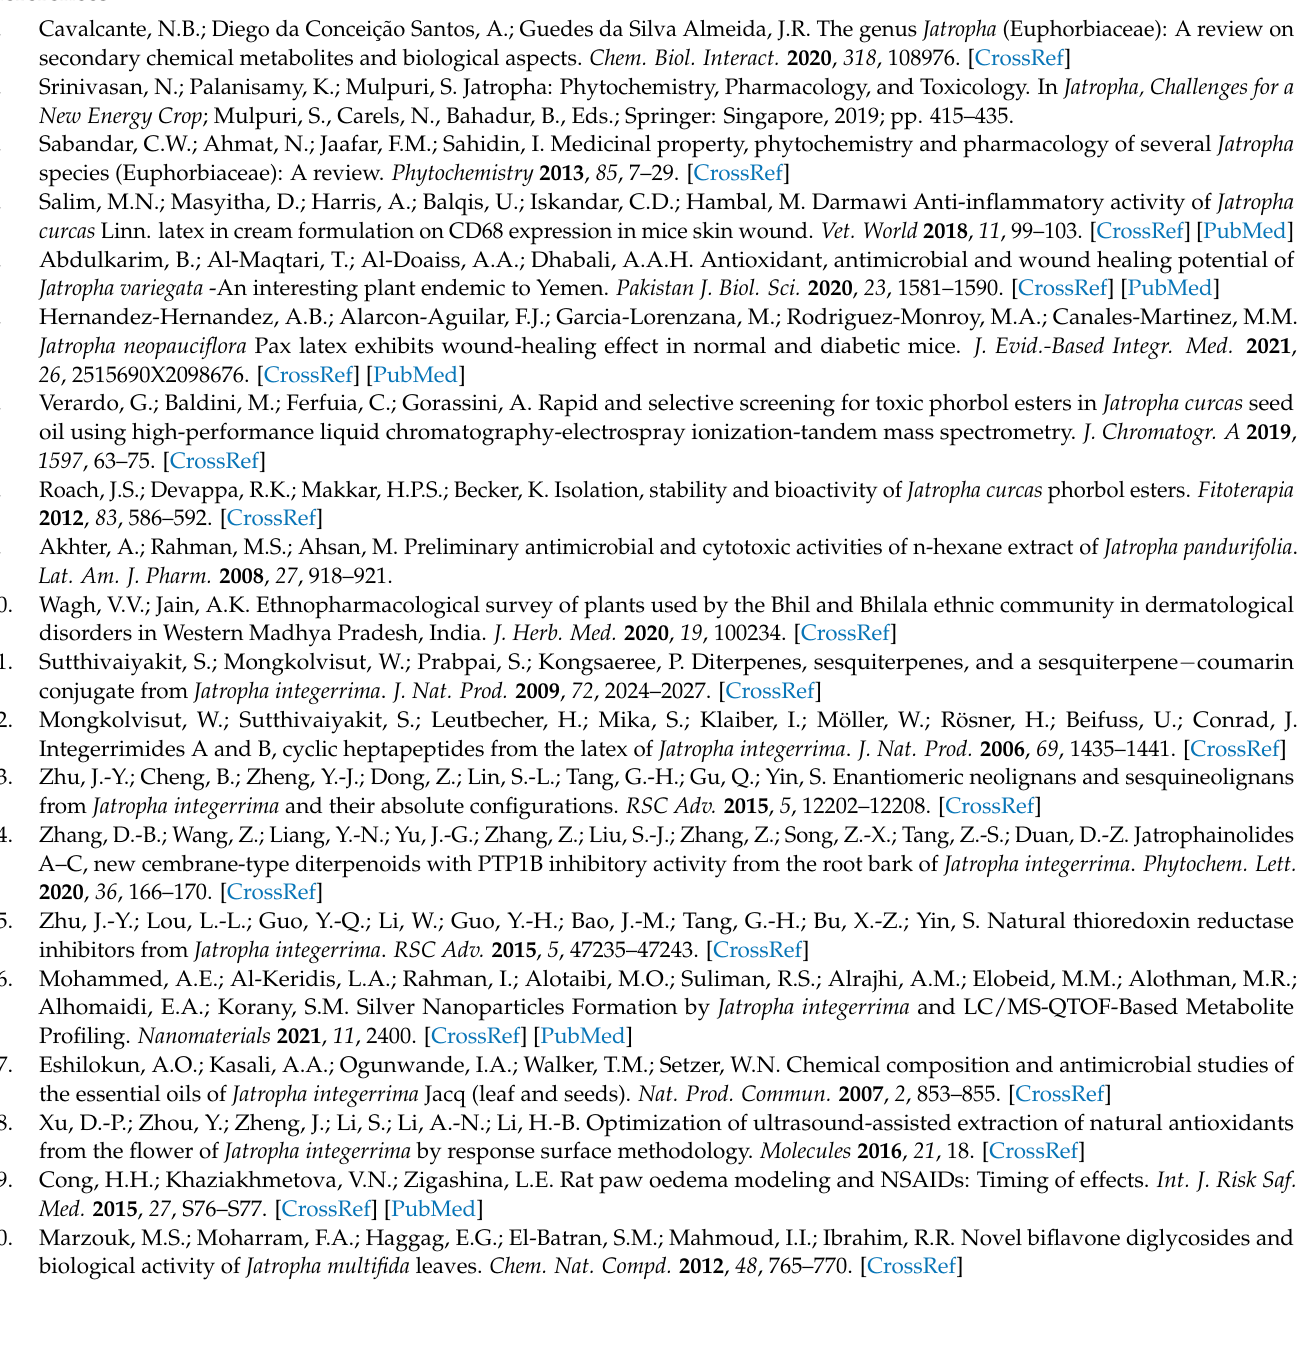
Monopalmitin; Figure S18: MS/MS of peak 84: Phosphatidic acid (10:0/9:0); Figure S19: MS/MS of peak 86: Lysophosphatidylcholine (16:0/0:0); Table S1: Analysis of high resolution MS/MS Q-TOF fragments for newly identified cyclic